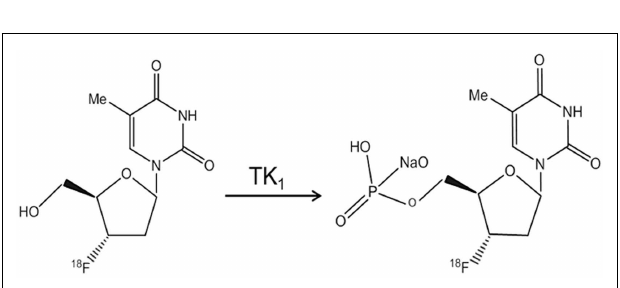
FIGURE 1 |The structure of [ 18 F]FLT and its phosphorylation by thymidine kinase 1 (TK 1 ) .